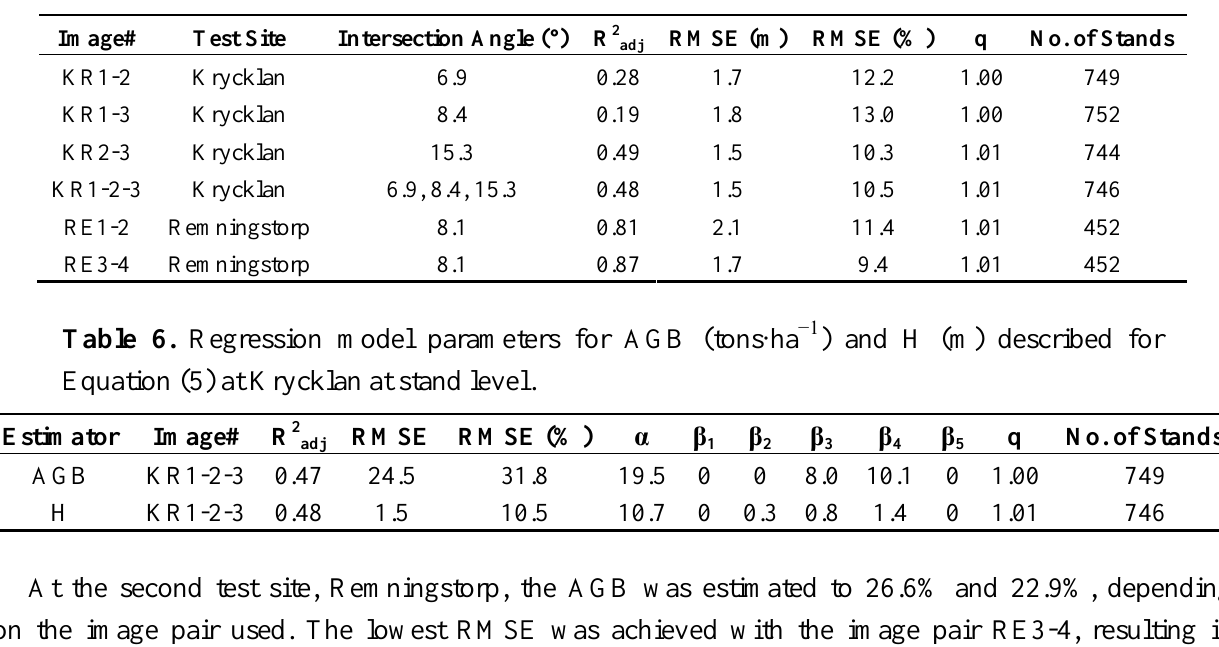
Table 5. The results for estimating H at both test sites.